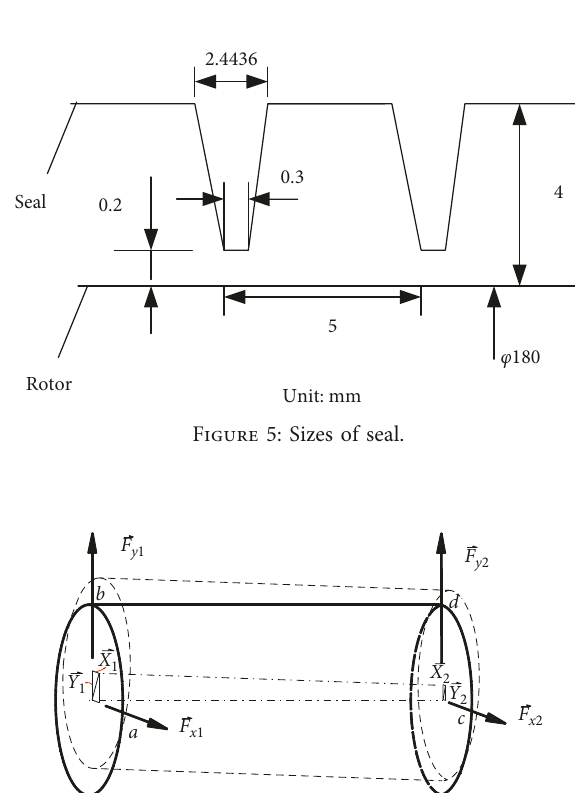
Figure 6: Seal force equivalent model and cylinder dynamic